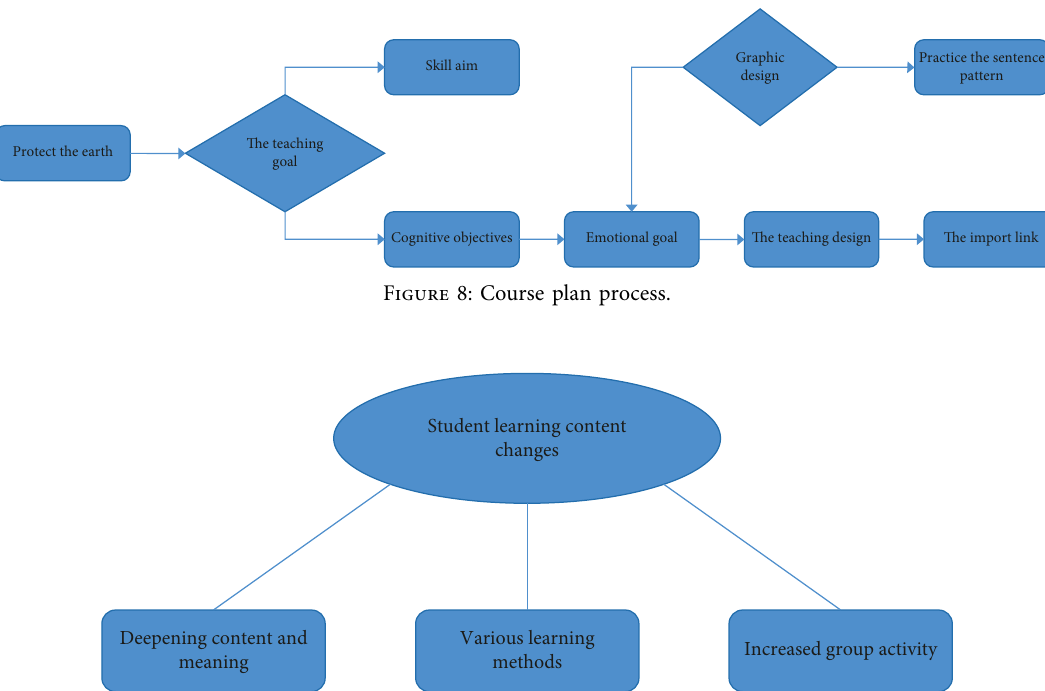
Figure 9: Characteristics of students’ learning